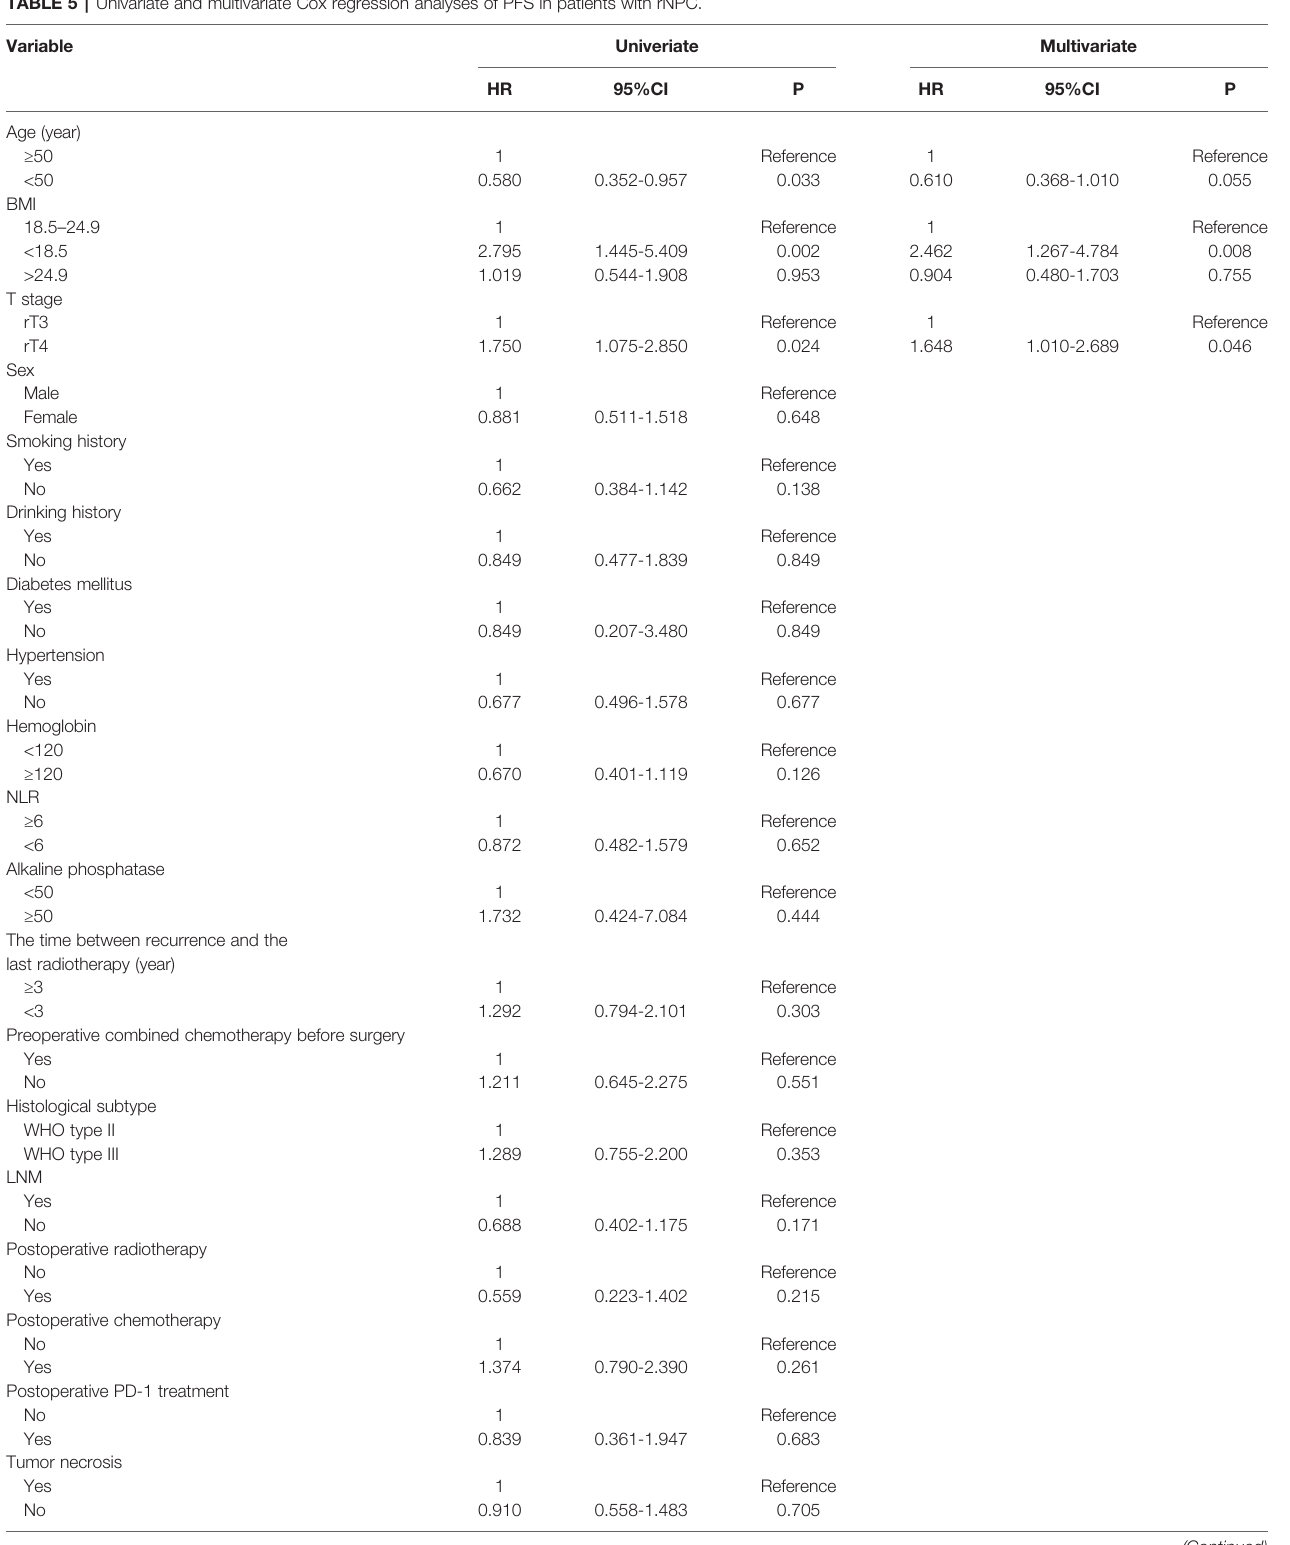
TABLE 5 | Univariate and multivariate Cox regression analyses of PFS in patients with